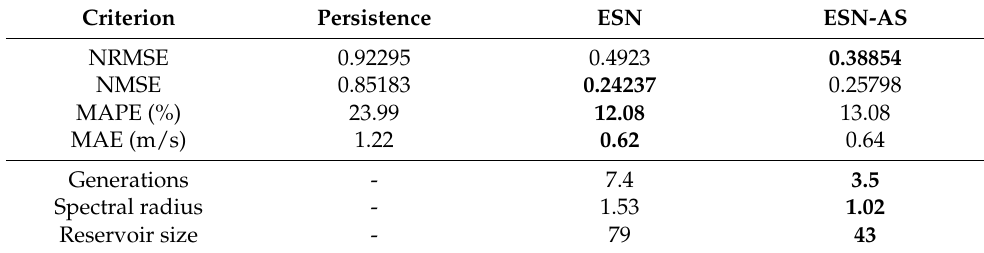
Table 4. Average test performance—BJD.